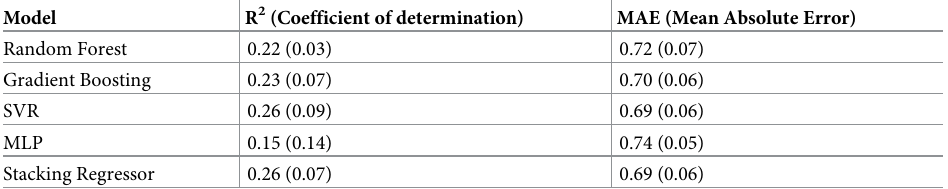
Table 4. 5-fold cross-validation performance of different machine learning models on training dataset for females.